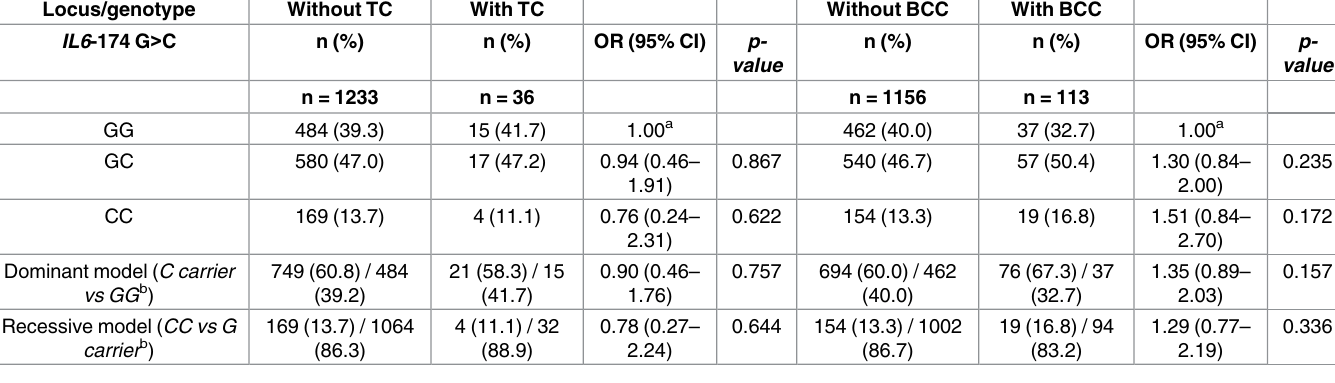
Table 2. Genotypic frequencies and association of the IL6 -174 SNP with thyroid carcinoma and basal cell carcinoma (adjusted for gender an age). Locus/genotype